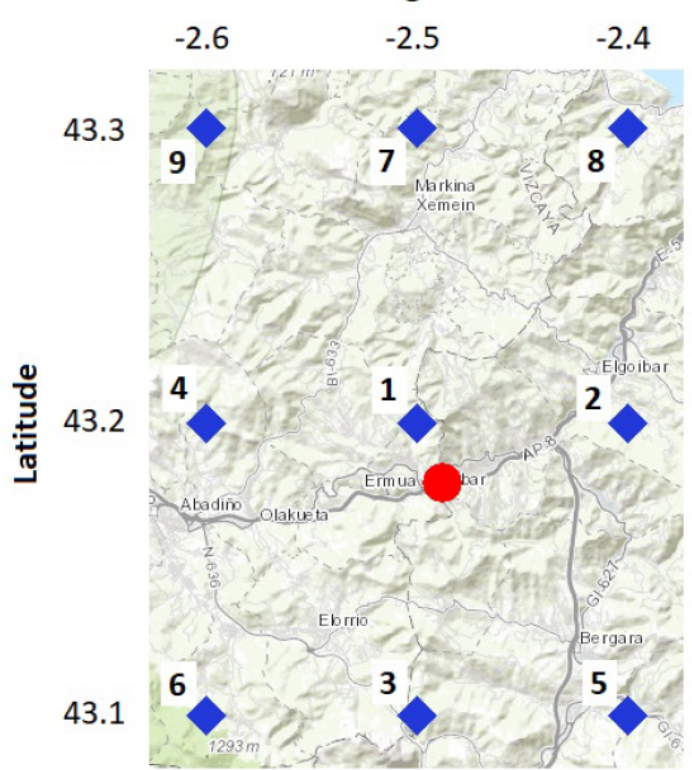
Figure 2. Location of the studied building ( red ) and ERA5 grid points ( blue ). The grid points are numbered according to their proximity to the